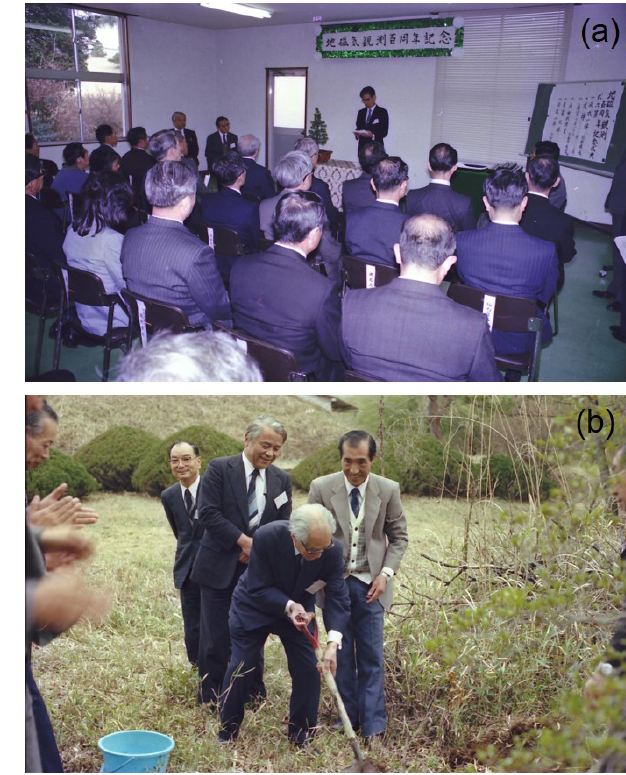
Figure 28. The ceremony of the centennial anniversary of geomag- netic field observation in Japan and the 70th anniversary of geo- magnetic field observation at Kakioka held in March 1983. (a) A speech by Masuzawa, director general of the Japan Meteorological Agency, and (b) memorial tree planting by Imamichi, the first direc- tor of Kakioka Magnetic Observatory (photo supplied by Kakioka Magnetic